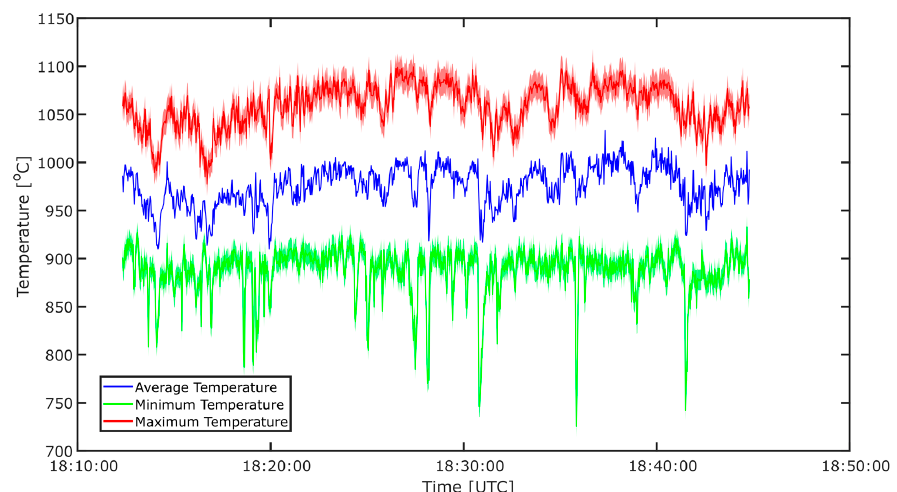
Figure 6. Temperature time series from 18:12:20 to 18:44:48 UTC on 12 June 2017, taken with a 1 ms shutter speed at a framerate of 0.5 Hz. Maximum, minimum and average temperatures of the lava lake region of interest (ROI) and displayed. Maximum and minimum temperatures have associated total uncertainties displayed as a shaded region.